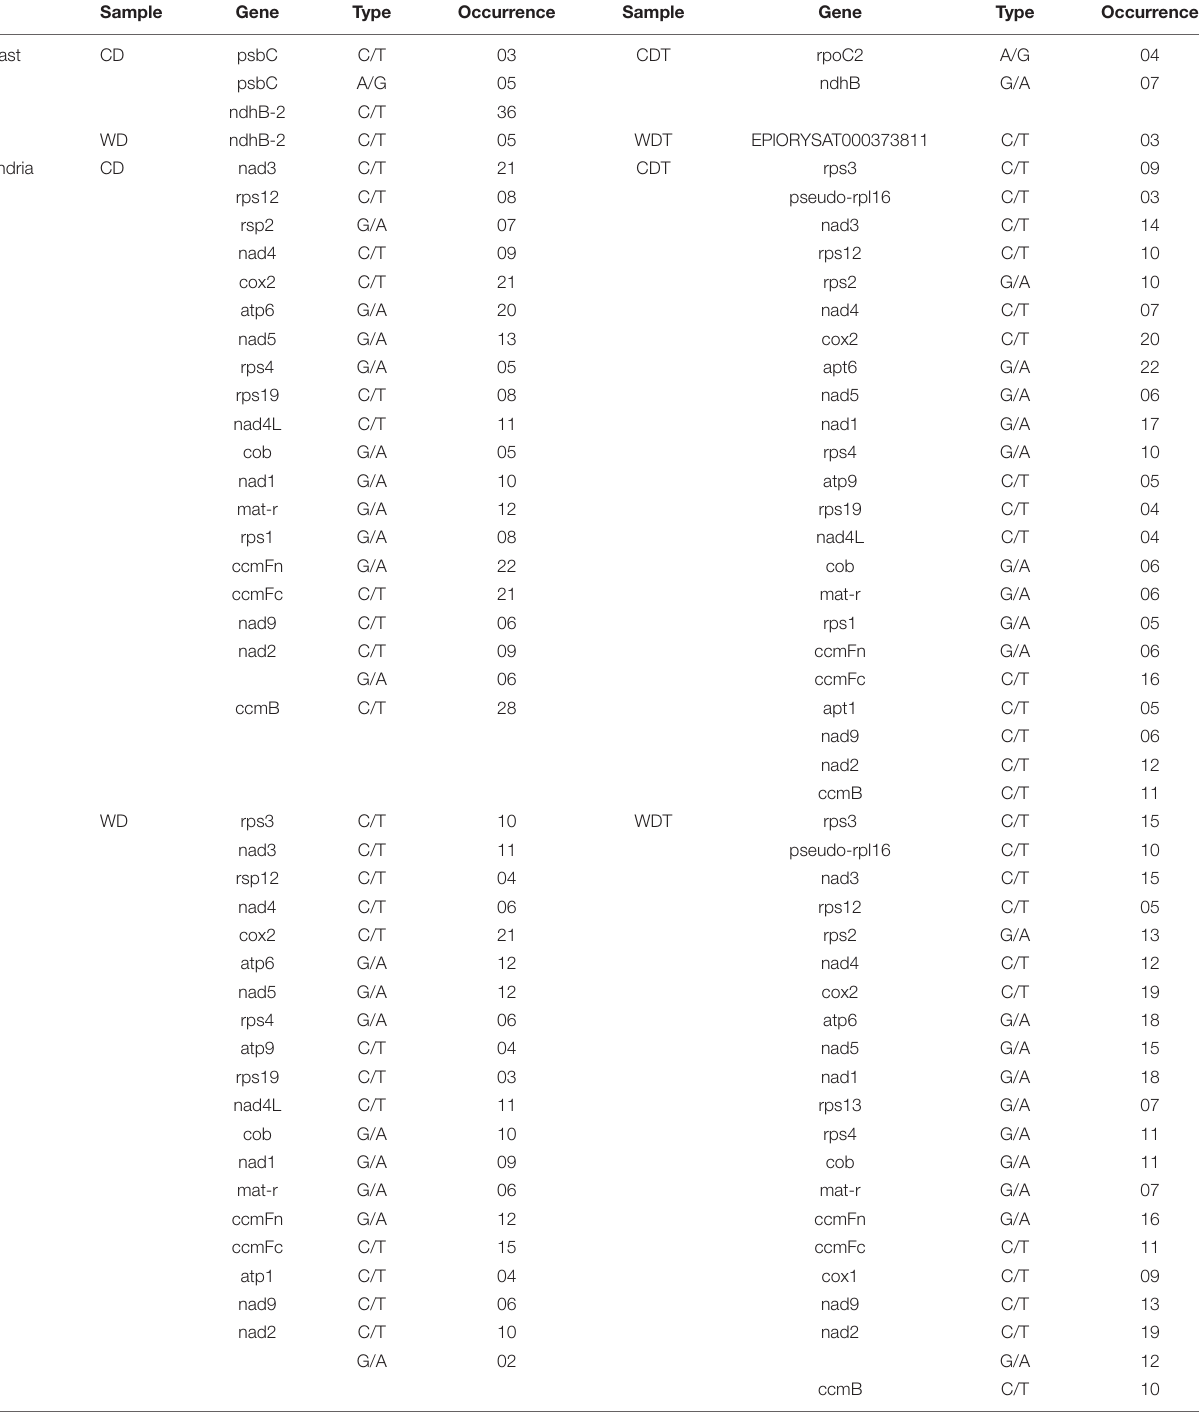
TABLE 3 | Mitochondrial RNA editing sites in genes, type of editing, and their occurrence in four samples of rice. Sample Gene Type Occurrence Sample Gene Type